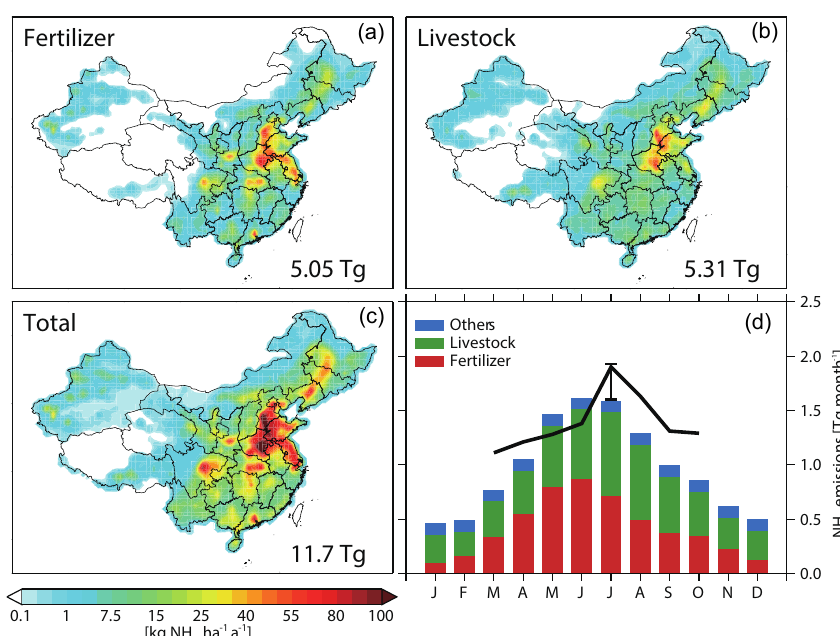
Figure 7. Improved bottom-up NH 3 emission estimates from fertilizer use (a) , livestock (b) , and total anthropogenic emissions (c) in China. Values inset are emission totals. Panel (d) shows seasonal variations in Chinese NH 3 emissions from different source categories. The bars represent our bottom-up estimates and the black line shows adjoint optimized anthropogenic totals for March–October. The vertical black line denotes the range of top-down estimates from inversions with different error configurations for the July month as described in the